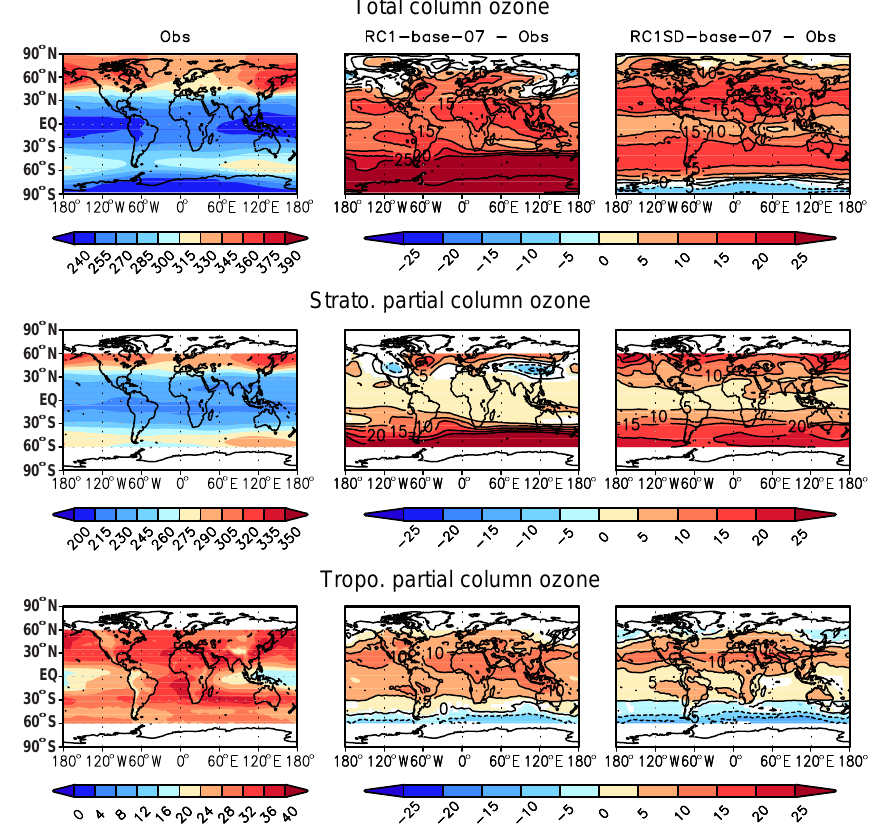
Figure 29. Left column: climatological annual mean of observed total column ozone (BSTCO, top) as well as stratospheric (middle) and tropospheric (bottom) partial column ozone (AURA MLS/OMI), all in DU. The tropospheric and stratospheric partial columns are integrated from the surface to the (on-line diagnosed, see text) tropopause and above the tropopause, respectively. The analyses cover the years 2005 to 2011. Middle column: differences between the RC1-base-07 simulation and the observations. Right column: same as middle column, but for the RC1SD-base-07 simulation. Statistically significant changes on the 95% confidence level are